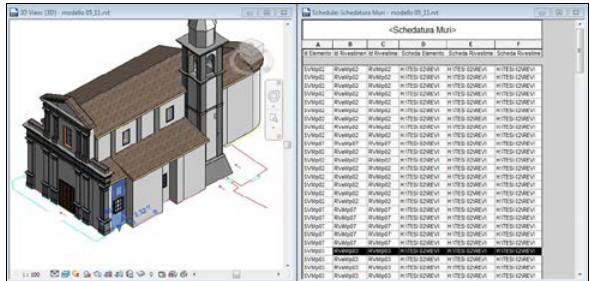
Figure 8. The BIM model of the church of Galvagnina with the linked data of the state of conservation and restoration